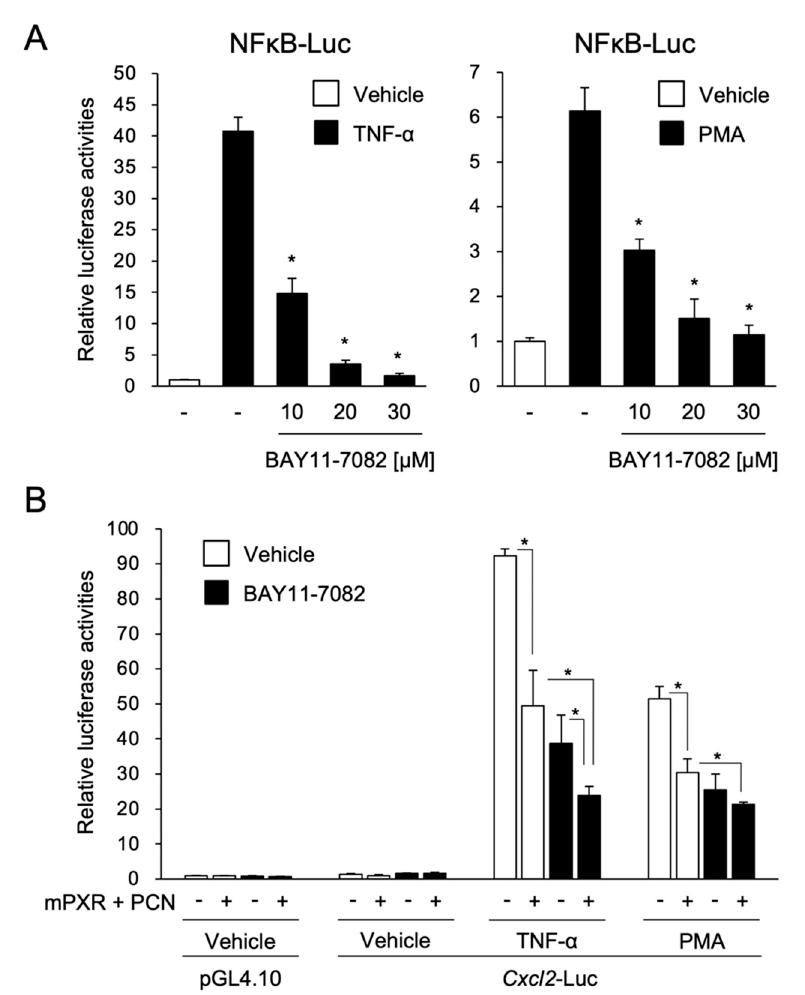
Figure 4. E ff ect of the nuclear factor kappa B (NF- κ B) inhibitor and PXR activation on Cxcl2 expression. ( A ) 293T cells were transfected with NF κ B-Luc and control phRL-TK (total DNA: 100 ng / well). The cells were treated with 10 ng / mL TNF- α , 10 nM phorbol 12-myristate 13-acetate (PMA), or vehicle (0.1% DMSO) with or without 10, 20, or 30 µ M BAY11-7082 for 24 h, and reporter activity was determined. Relative activity is shown compared to that in the cells treated with vehicle only (open bars) as 1. Values are presented as mean ± SD ( n = 4). Statistical di ff erences among the TNF- α -treated groups were analyzed using one-way ANOVA followed by the Dunnett’s test, with the cells without BAY11-7082 treatment as a control group (* p < 0.05). ( B ) 293T cells were transfected with Cxcl2 -Luc or control pGL4.10, mPXR-pTargeT (10 ng) or control pTargeT, and control phRL-TK (total DNA: 100 ng / well). The cells were treated with 10 ng / mL TNF- α , 10 nM PMA, or vehicle (0.1% DMSO) in combination with or without 30 µ M BAY11-7082 and 10 µ M PCN for 24 h, and reporter activity was determined. Relative activity is shown compared to that in the cells transfected with pGL4.10 and control pTargeT and treated with vehicle only (the left-end open bar) as 1. Values are presented as mean ± SD ( n = 4). Di ff erence within the TNF- α - or PMA-treated groups were analyzed using one-way ANOVA followed by the Tukey–Kramer test (* p <